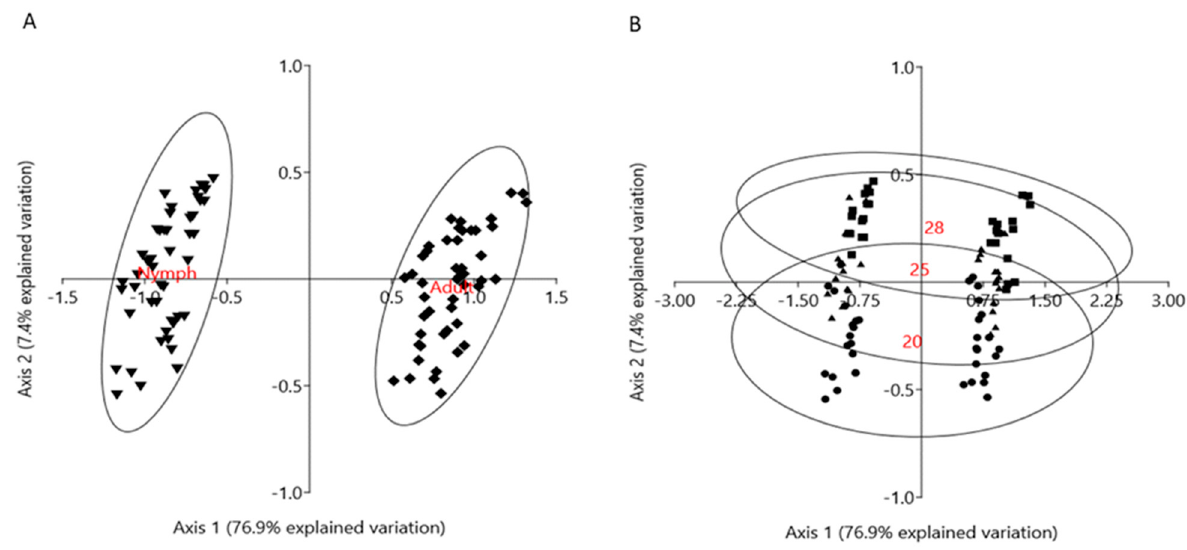
Figure 1. Principal component analysis (PCA) of enzyme data from three aphid species. ( A ) The first axis (PC1) segregated the enzyme data according to aphid developmental stage, and to a lesser extent, according to temperature (inverted triangle—nymphs, diamond—adults). ( B ) The second axis (PC2) segregated the enzyme data according to temperature (dot—20 °C, triangle—25 °C, square—28 °C). The groups are marked with 95% ellipses.